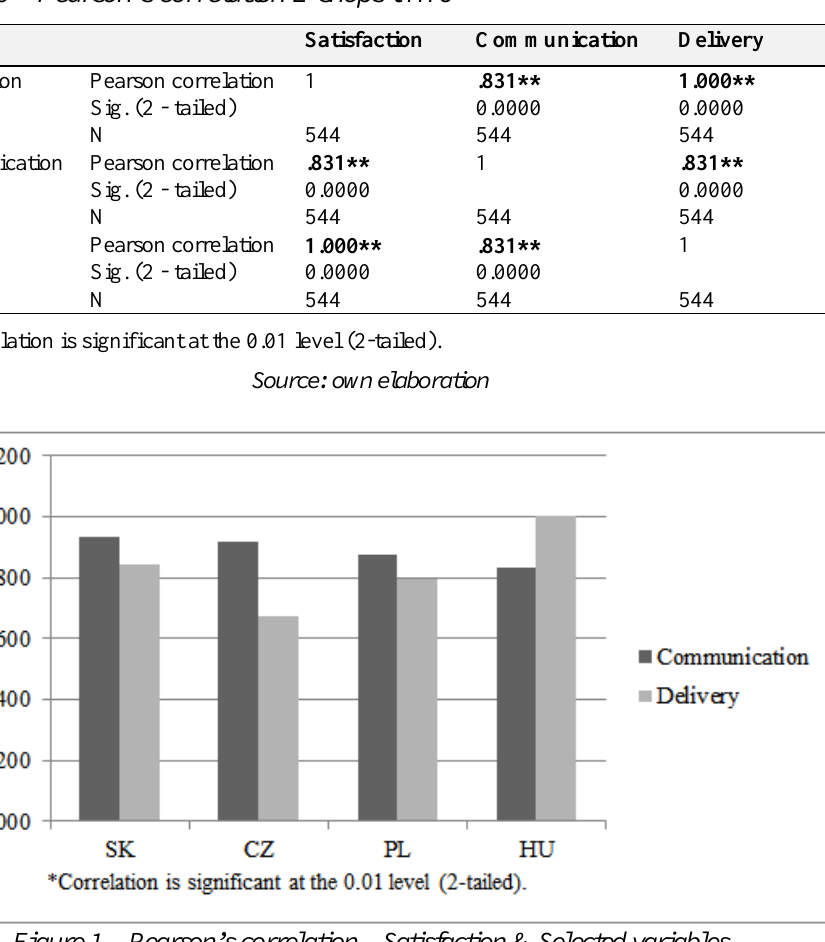
Table 10 – Pearson’s correlation E-shops in HU